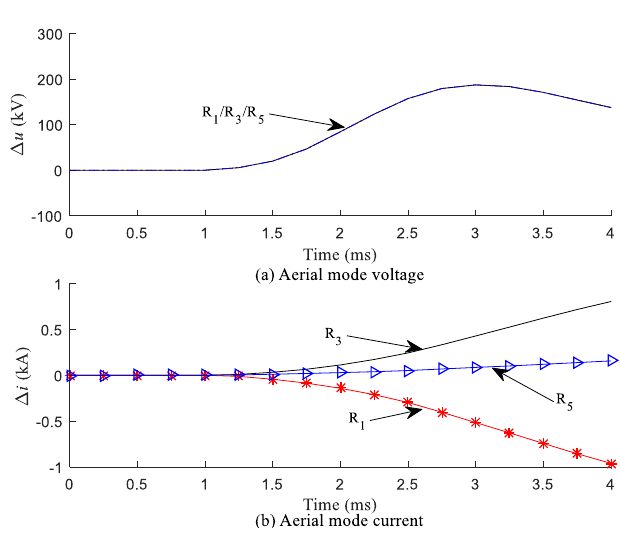
Figure 9. The aerial mode components that were detected by R 1 , R 3 , and R 5 for an external fault: the ( a ) aerial mode voltage and the ( b ) aerial mode current.